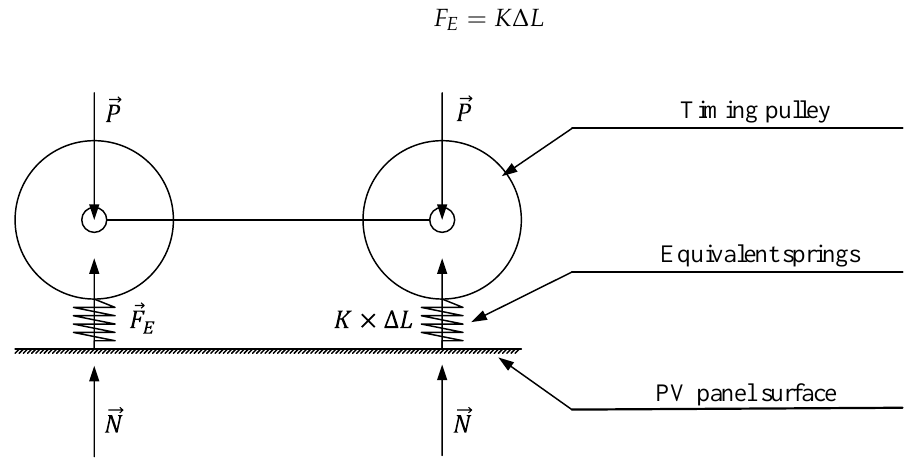
Figure 2. Equivalent model of rubber track pad coating